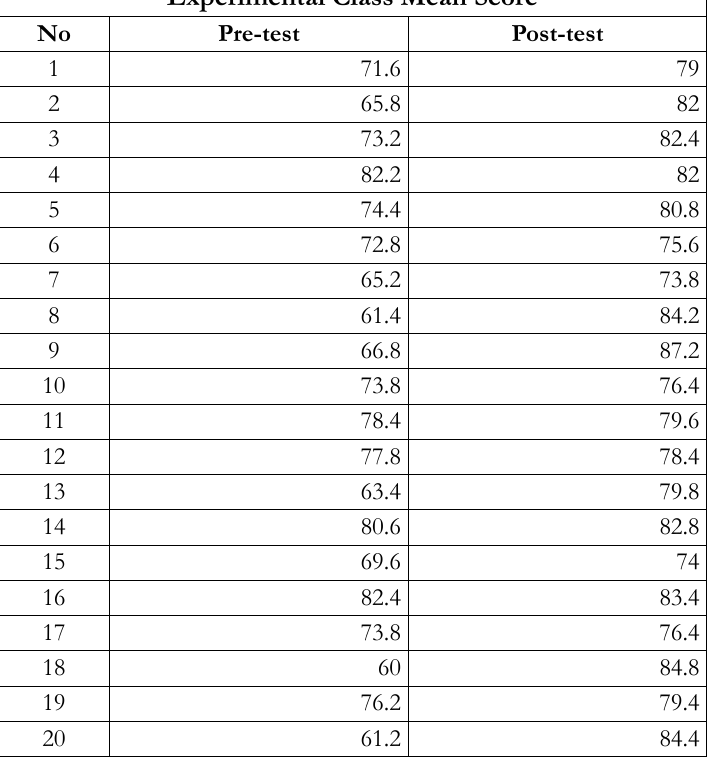
Table 1. The scores of the Experimental Class on Pre-test and Post-test